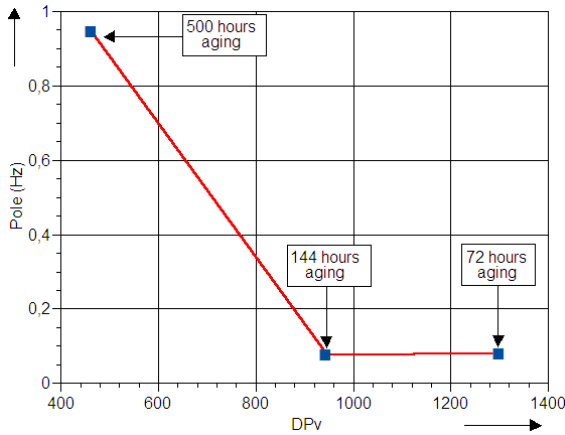
Figure 9. Relationship between the derived poles and degree of polymerisation (DP v ) of the oil impregnated pressboard